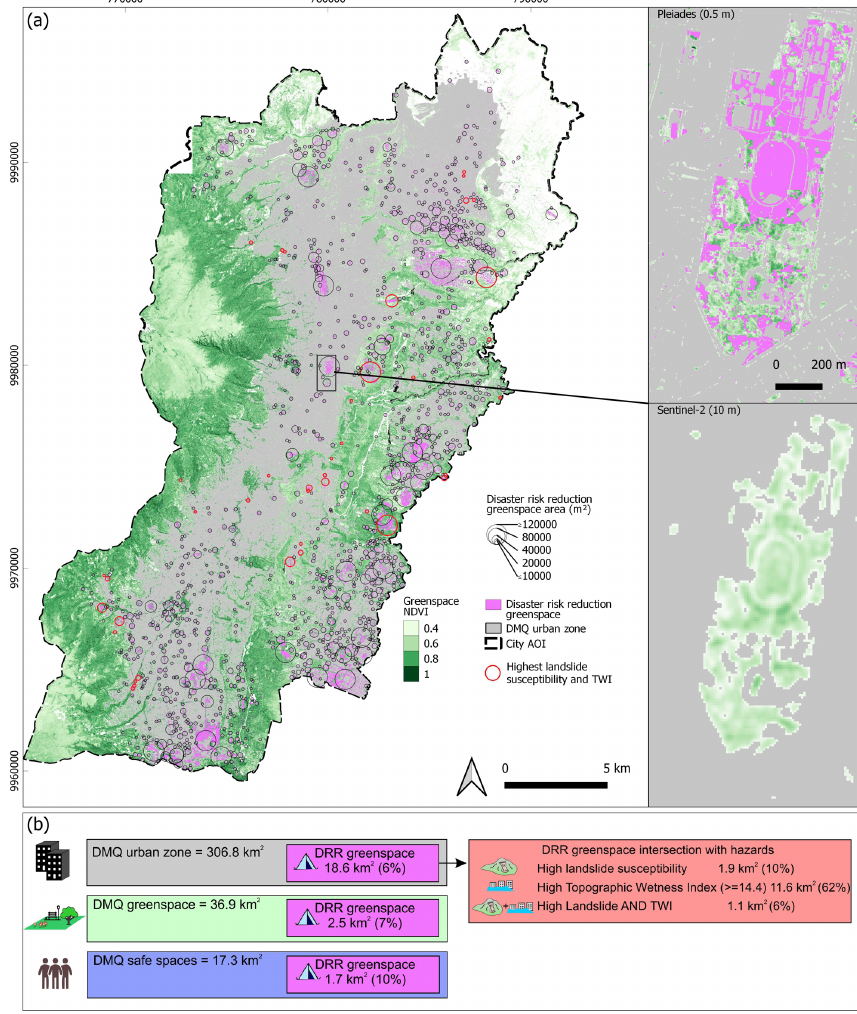
Figure 8. (a) Greenspace mapped using the NDVI applied to Pleiades satellite imagery shown with classified potential DRR greenspace (black and red circles, pink shading). Red circles indicate DRR greenspace that intersects with landslide susceptibility class 5 (high) and a topographic wetness index value of ≥ 14.4 (median value for clustered flood events; Sect. 4.2). The inset of Carolina Park shows the similarity of Pleiades-derived greenspace compared to greenspace mapped using Sentinel-2 imagery. The Pleiades inset shows the distribution of potential DRR greenspace (pink) in Carolina Park. (b) Summary of greenspace availability and hazard